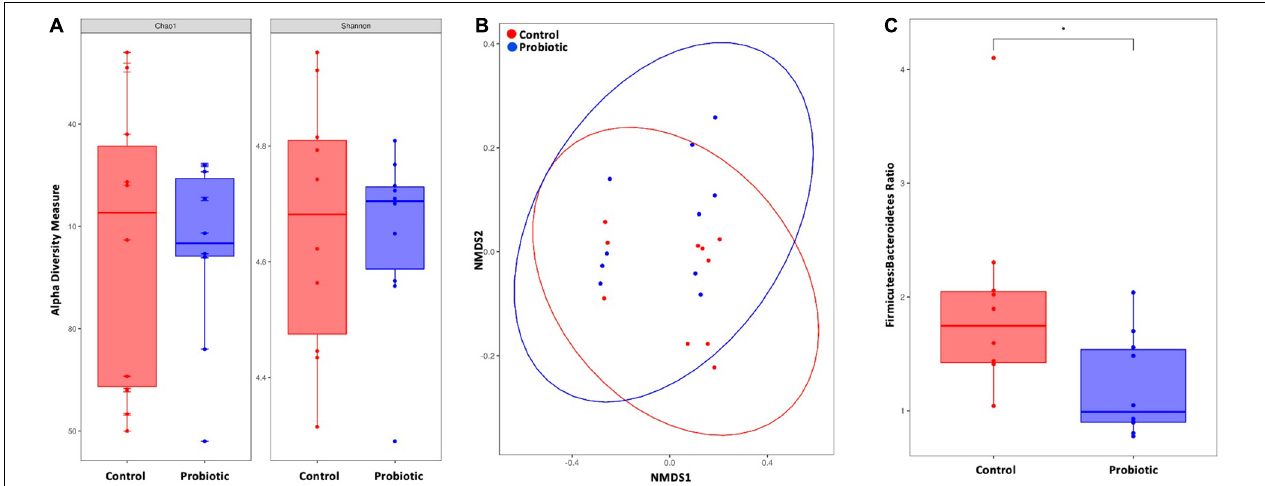
FIGURE 5 | The composition of the faecal microbiota by NGS. (A) Alpha diversity indices of richness and diversity and (B) non-metric dimensional scaling (NMDS) based on weighted UniFrac distances matrix. Permutational analysis of variance was performed with caging as a strata effect. 10,000 permutations were applied.